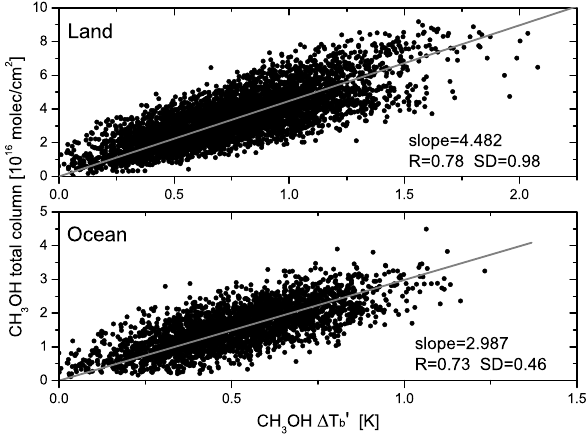
Fig. 5. Correlation between the retrieved total columns of methanol and the corresponding 1T b for various regions (corrected for O 3 and H 2 O dependency, see text for details). The conversion factors are given by the slopes of the linear fit (gray curve) separated for re- trievals above land (Top panel) and above ocean (Bottom panel). More details about the selected regions for the retrievals can be found in Table